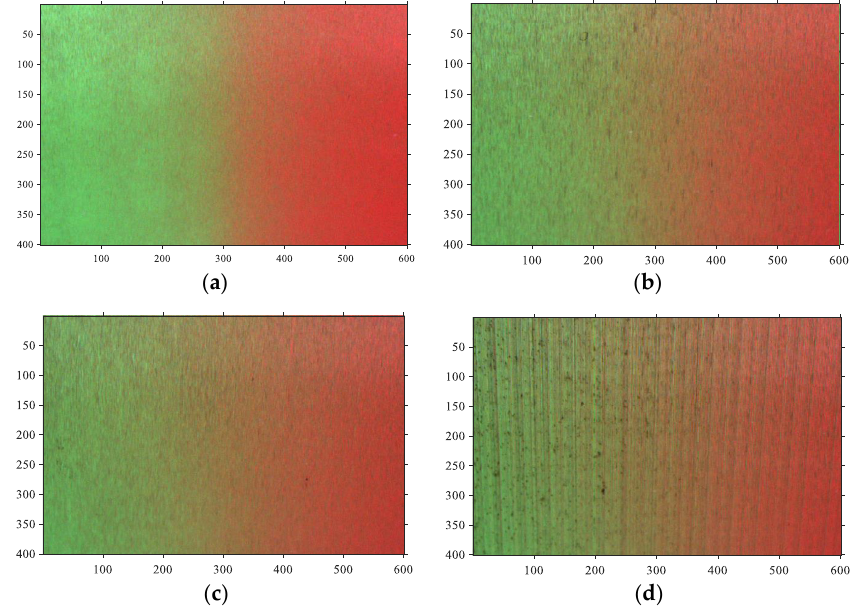
Figure 5. Experimental model and device.